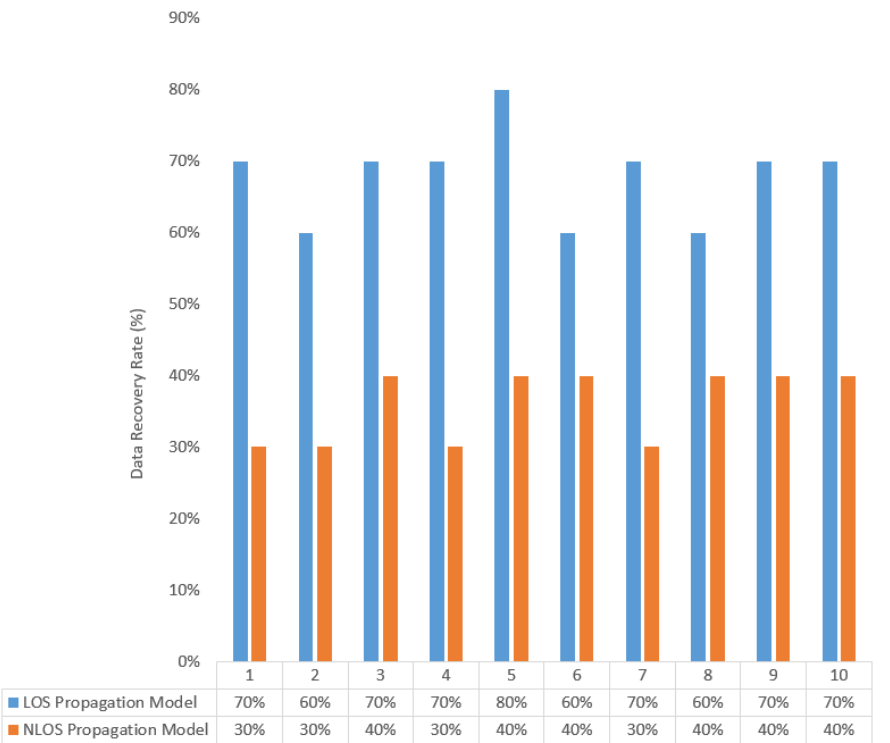
Figure 22. VLC hardware test